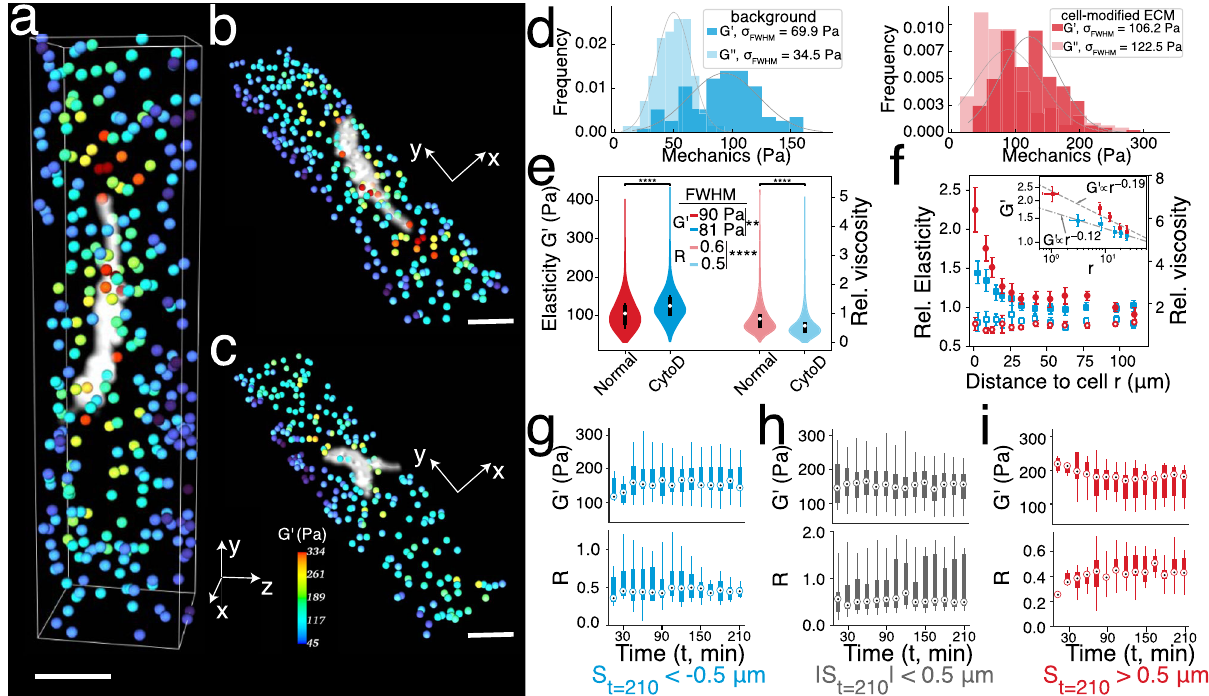
Fig. 3 Live-cell imaging of cell-mediated spatiotemporal variations in ECM micromechanical properties. a 3D LS-pfOCE measurements of G ′ (colour- coded beads) around a cell (white) and z -projection of 3D measurements under b , normal condition and c , 2 h after treatment with CytoD ( b and c show two different cells). Size of the beads is not to scale with the cell body. (DMSO control of CytoD treatment is provided in Supplementary Data 1. The normal condition in b did not receive DMSO, see “ Methods ” for sample preparation and live-cell imaging protocol.) All images share the same colour scale. (See Supplementary Videos 1 and 2 for visualisation of b and c from different viewing angles). Scale bar, 50 μ m. d Histograms and distribution fi ts of 3D LS- pfOCE measurements in the pericellular (red, N = 205 beads) and cell-free regions (blue, N = 97 beads) from 1 cell . σ FWHM indicates the FWHM of the distributions. e Violin plots of 3D LS-pfOCE measurements around cells under normal (red, N = 1824 beads) and CytoD (blue, N = 1567 beads) conditions from 8 cells. Marker indicates median and black bar spans 1st to 3rd quartile. The FWHM of each distribution is stated. Signi fi cant difference in group means (two-sided Welch ’ s t -test) and variance (Levene ’ s test) is indicated by ** p value < 0.01 and **** p value < 0.0001. f 3D LS-pfOCE measurements of G ′ (solid marker) and R (open marker) from the data in e , normalised by the measurements in faraway background regions ( ≥ 30 µ m from cell) in each sample, as a function of distance to the cell under normal (red) and CytoD (blue) conditions. Inset shows power law fi ts within <30 µ m to cell; the decay exponent has a 95% con fi dence interval of – 0.19 ± 0.08 (red) and – 0.12 ± 0.003 (blue). Each data point represents mean ± standard deviation from N ≥ 20 beads. g – i Boxplots of G ′ (top) and R (bottom) from 5 cells as a function of time after CytoD treatment in regions that experience high-negative (blue, N = 10 beads), low (grey, N = 16 beads), and high-positive (red, N = 8 beads) matrix deformation S , respectively. Marker indicates median, box spans 1st to 3rd quartile, and whisker spans the full range of